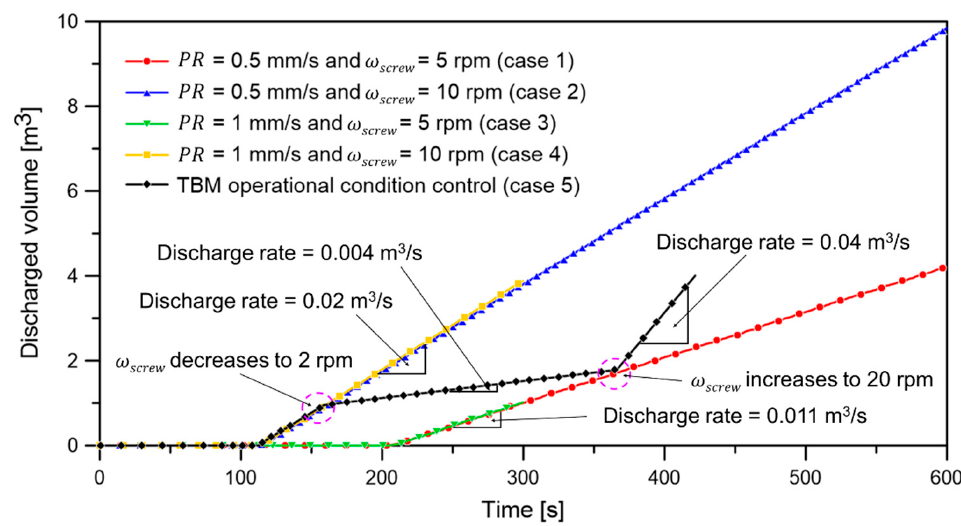
Figure 14. Measured discharged volume and discharge rate data during EPB shield tunnelling simulation.